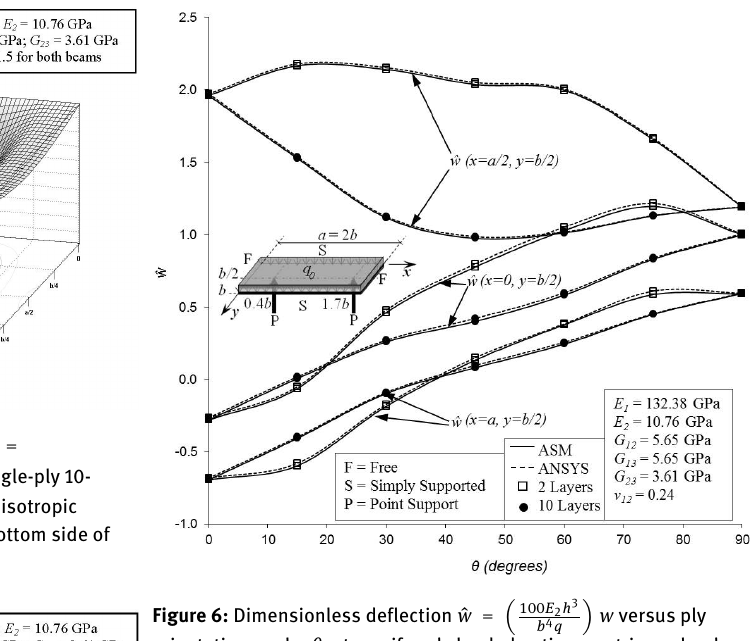
Figure 6: Dimensionless deflection ^ w = orientation angle, θ , at a uniformly loaded antisymmetric angle-ply rectangular laminated plate ( a / b = 2 ) having two internal point supports at x = 0.4 b , y = b /2 and x = 1.7 b , y = b /2 .